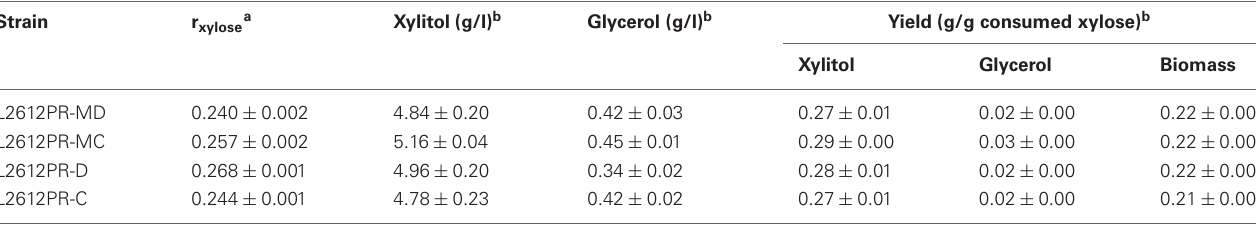
Table 5 | Aerobic xylose consumption of L2612PR-MD, L2612PR-MC, L2612PR-D, and L2612PR-C. Strain r xylosea Xylitol (g/l)